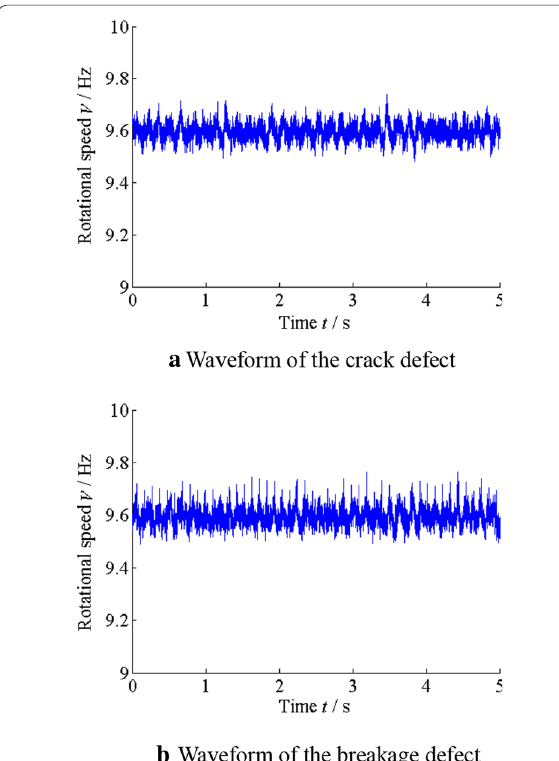
Figure 11 Spectra of instantaneous speed of the input shaft